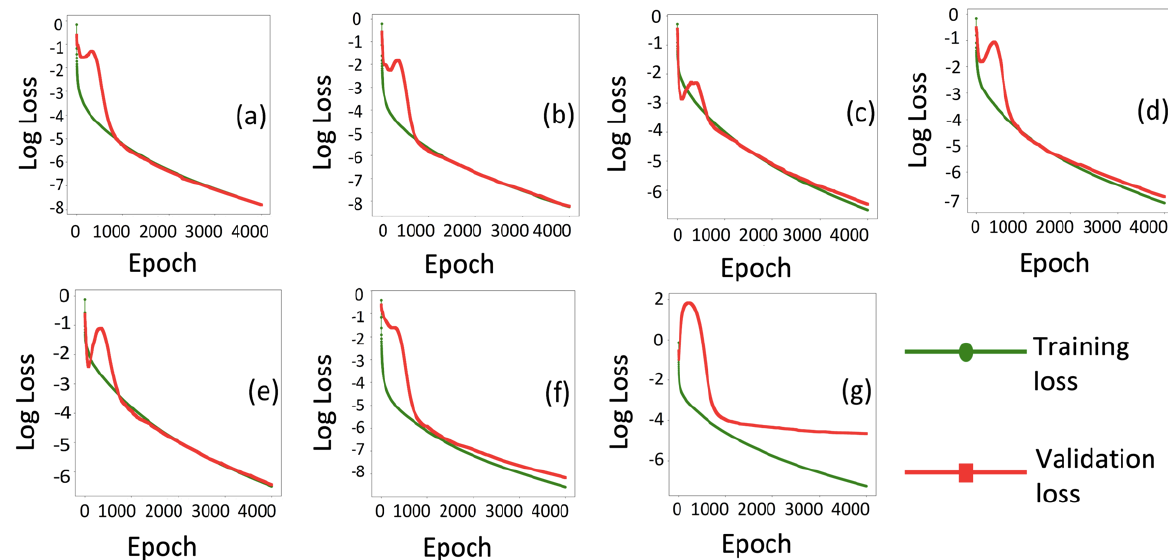
Figure 10. Training and validation log losses vs. number of iterations for independent classifiers ( a ) class 1; ( b ) class 2; ( c ) class 3; ( d ) class 4; ( e ) class 5; ( f ) class 6; ( g ) class 7.